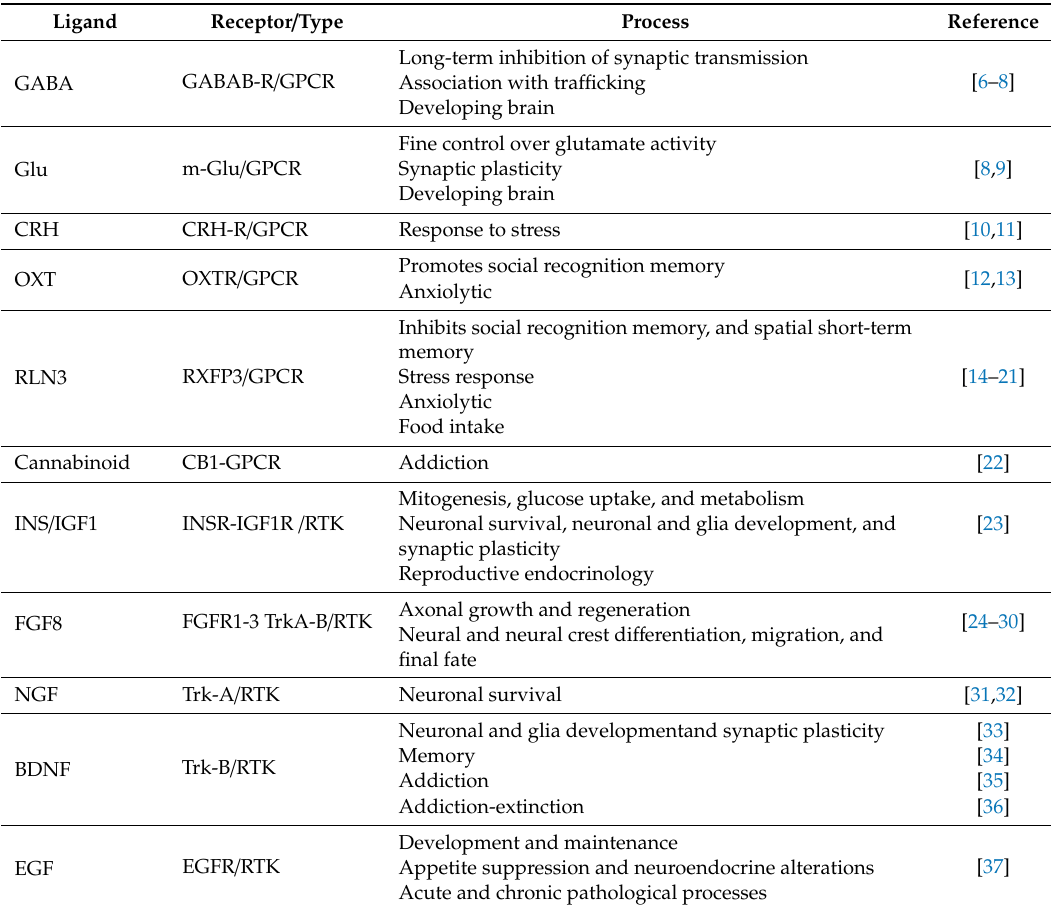
Table 1. Physiological function of the activation of the microtubule-associated protein kinase or extracellular regulated kinase (MAPK / ERK) pathway via G-protein coupled receptors (GCPR) or receptor tyrosine kinase (RTK)